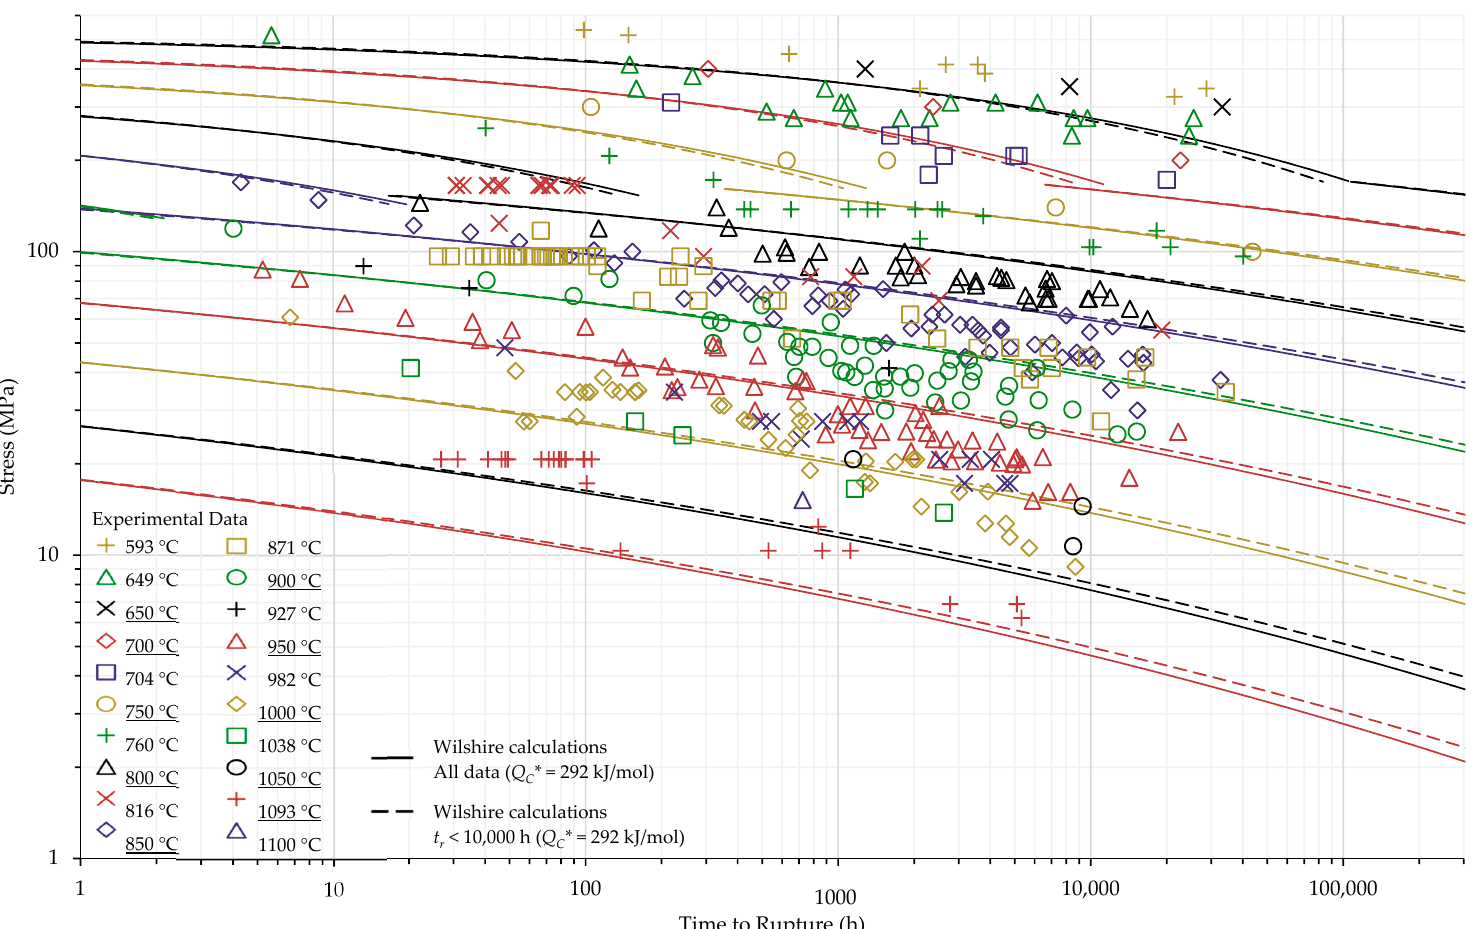
Figure A13. Single region calculations of the Wilshire equation with the self-diffusion activation energy of nickel in a nickel lattice as Q ∗ for Inconel 617 shown at underlined temperatures.